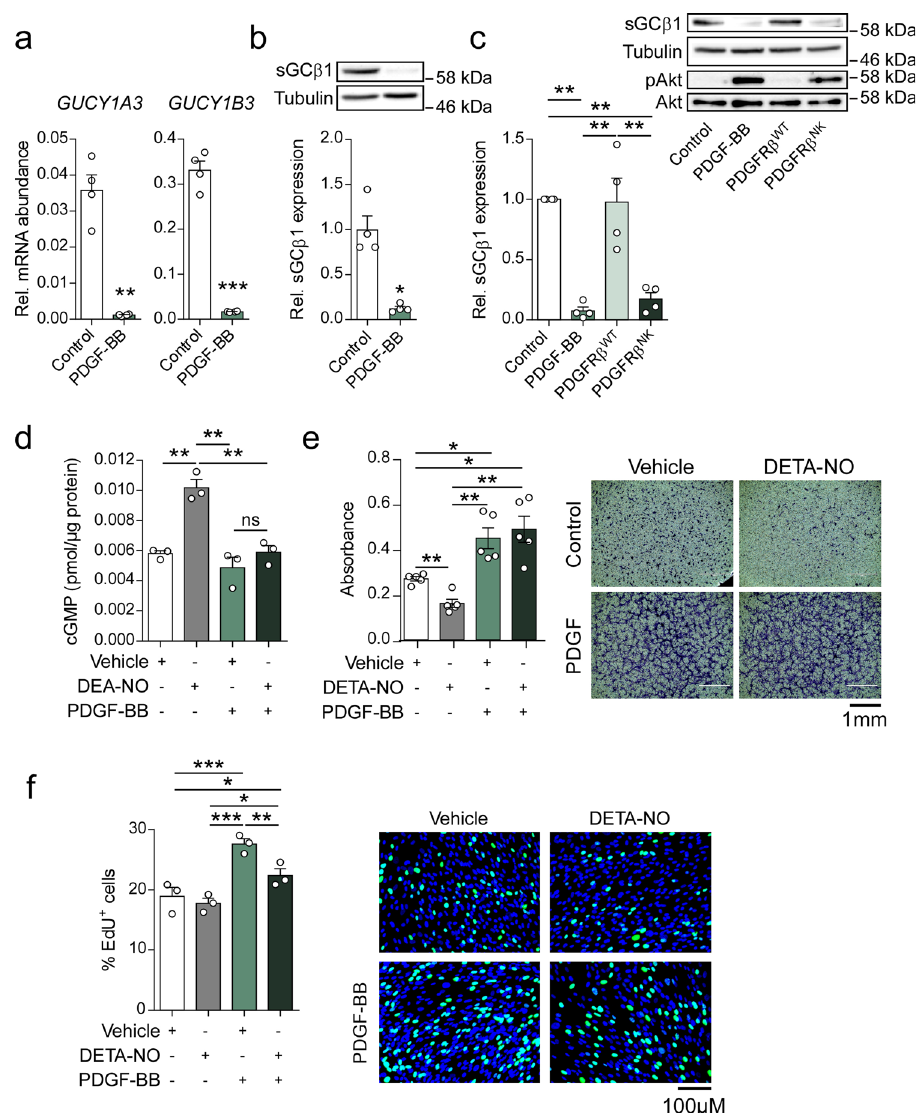
Fig. 1 PDGF-BB reduces sGC expression and the inhibitory effects of NO on VSMC migration. a GUCY1A3 and GUCY1B3 mRNA levels in hASMCs after treatment with PDGF-BB (100 ng/ml); t test; n = 4 independent experiments. b sGC β 1 protein expression in hASMCs after treatment with PDGF-BB; t test; n = 4 independent experiments. c sGC β 1 protein expression in hASMCs after treatment with PDGF-BB or transduction with either PDGFR β WT or PDGFR β NK ; ANOVA with Tukey ’ s multiple comparisons test; n = 4 independent experiments. d NO-induced (100 µ M DEA-NO) cGMP production in hASMCs after treatment with PDGF-BB; ANOVA with Tukey ’ s multiple comparisons test; n = 3 independent experiments. e NO-induced (100 µ M DETA- NO) inhibition of hASMC migration after treatment with PDGF-BB; ANOVA with Tukey ’ s multiple comparisons test; n = 5 independent experiments. Representative images from 5 independent replicates. f NO-induced inhibition (100 µ M DETA-NO) of hASMC proliferation after treatment with PDGF-BB; ANOVA with Tukey ’ s multiple comparisons test; n = 3 independent experiments. Representative images from 3 independent replicates. Bars